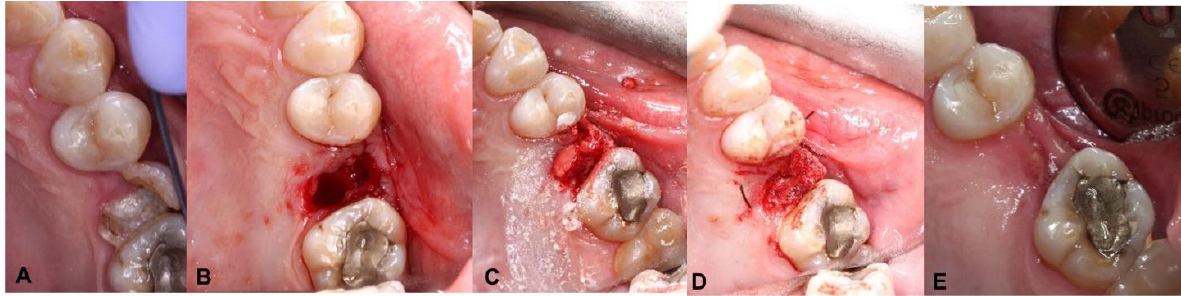
Figure 7. ( A ) Preoperative occlusal view; ( B ) Dental extraction of 25; ( C ) Placement of Bond Apatite ® ; ( D ) Postoperative occlusal view; ( E ) One-week follow-up.